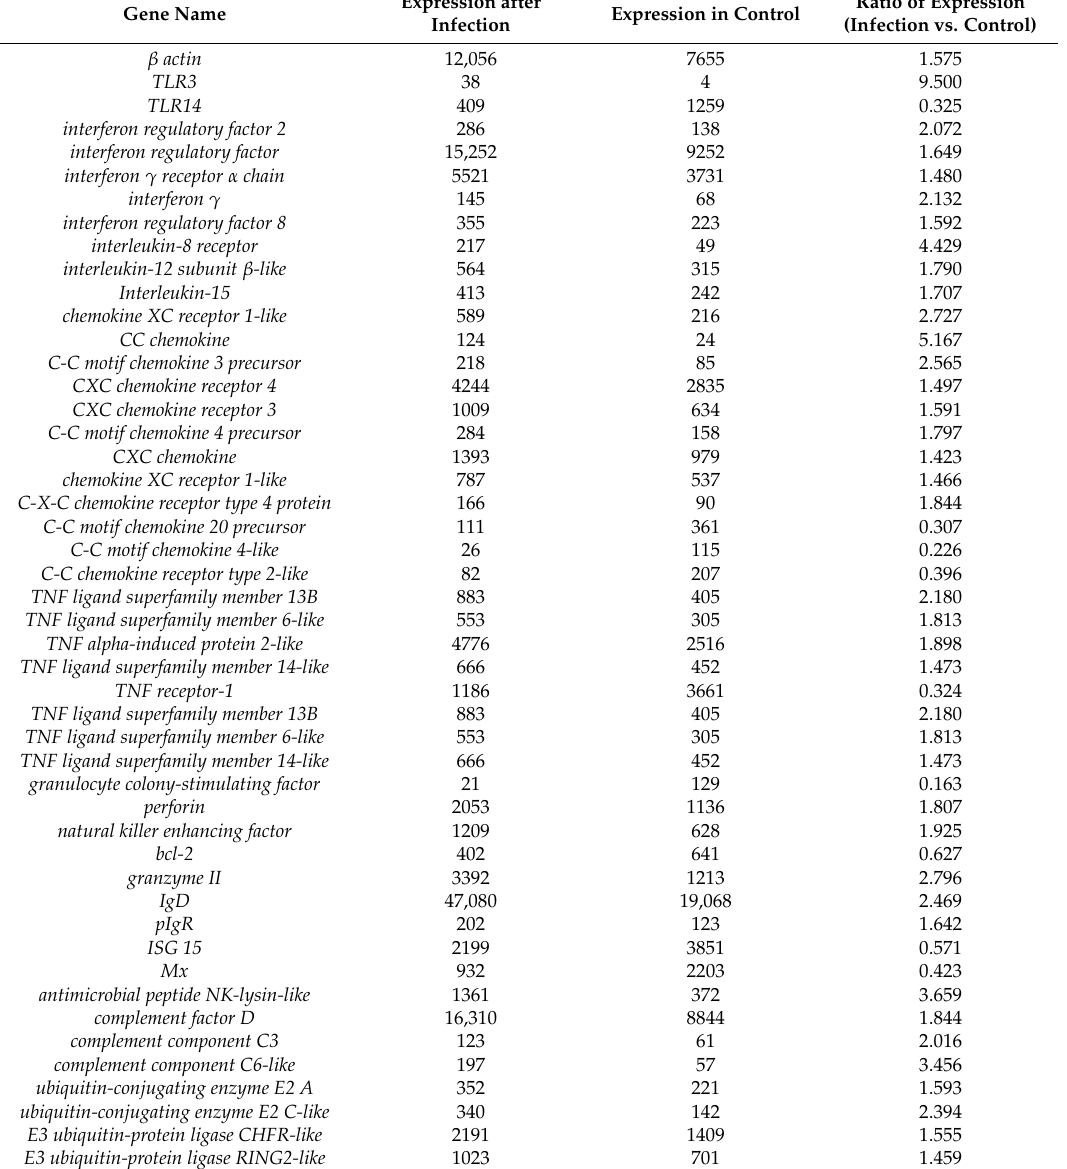
Table 5. Expression of virus-entry and immune-related DEGs in gill tissues at one week post LCDV